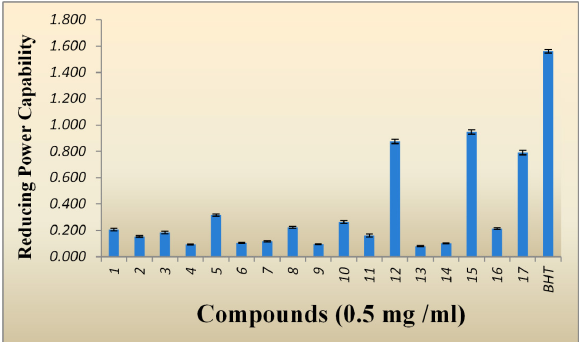
Each value is expressed as mean ± SD (n = 3). Figure: 2: Reducing power capability (absorbance at 700 nm) of compounds 1 - 17.